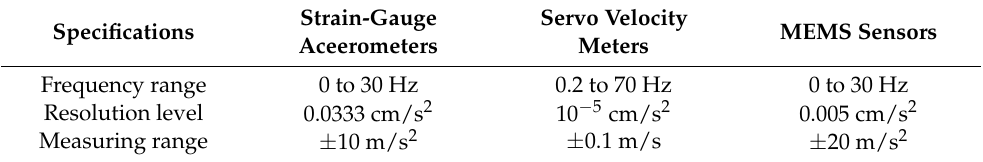
Figure 1. Sensors used in this study: ( a ) strain gauge accelerometer, ( b ) servo velocity meter and ( c ) MEMS accelerometer. Table 1. Specifications of sensors.